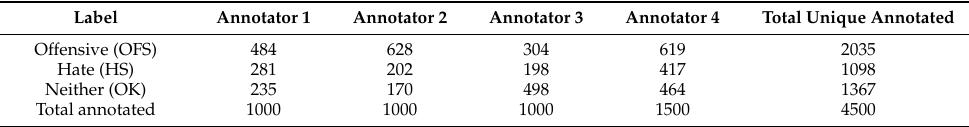
Table 3. Annotation result of unique posts and comments.